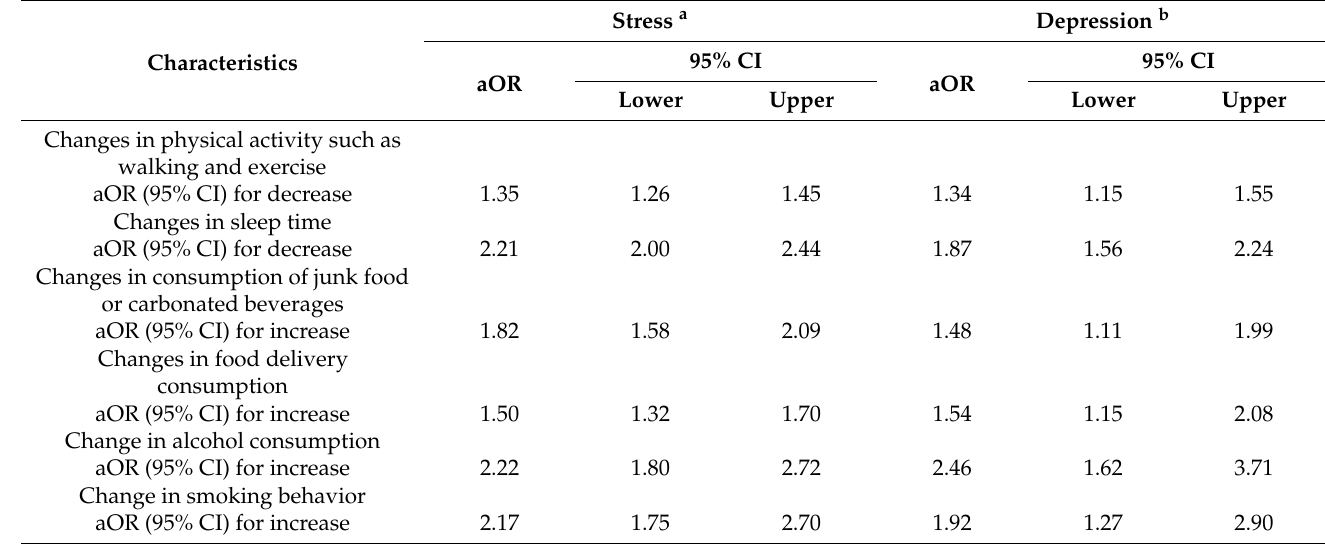
Table 3. Association between mental health status and unhealthy behavior changes among diabetes during the